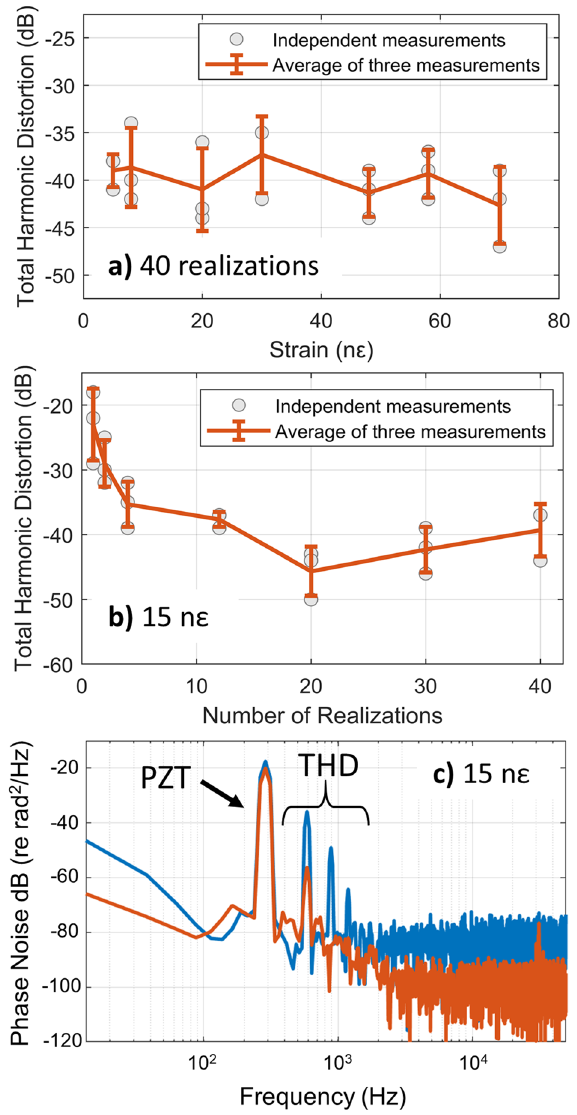
Figure 5. Analysis of the sensor linearity. ( a ) The total harmonic distortion at 5 distinct strain levels using 20 pulses (40 realizations). The measured THD remained below − 33 dB regardless of strain amplitude. The average of three independent experimental measurements are shown along with the standard deviation at each strain level. ( b ) The THD as a function of the number of realizations used to probe the FUT. The THD decreased rapidly as more realizations were used to obtain the average sensor response at a fixed strain amplitude of 15 n ε . ( c ) Example PSD obtained using 1 or 40 realizations with a 300 Hz strain. The THD was suppressed using 40